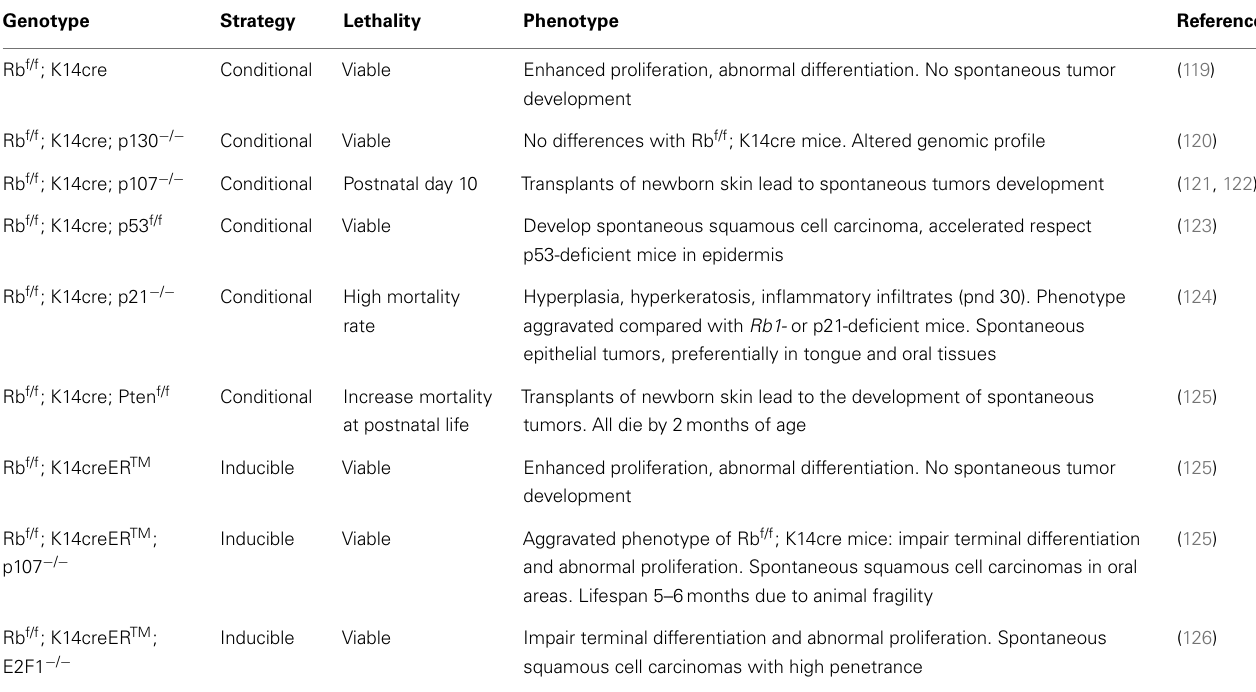
Table 2 | Phenotypic Skin abnormalities observed in mouse models lacking pRb in epidermis